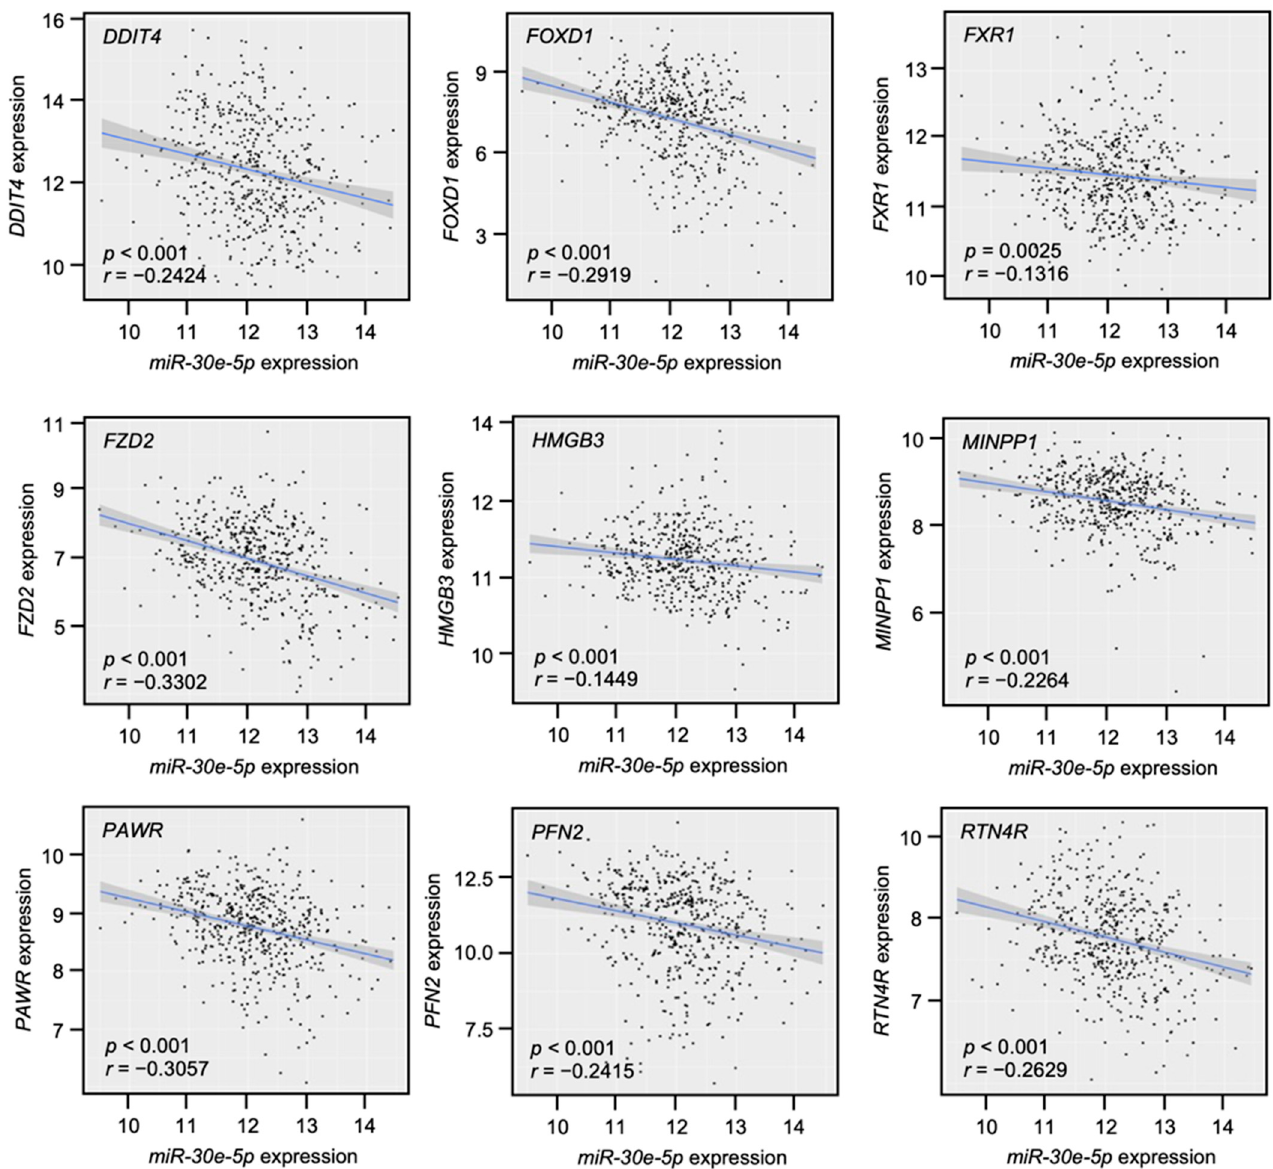
Figure 8. Correlation analysis by TCGA-HNSC for nine genes. Negative correlation of expression levels between miR-30e-5p and nine genes in HNSCC clinical specimens.